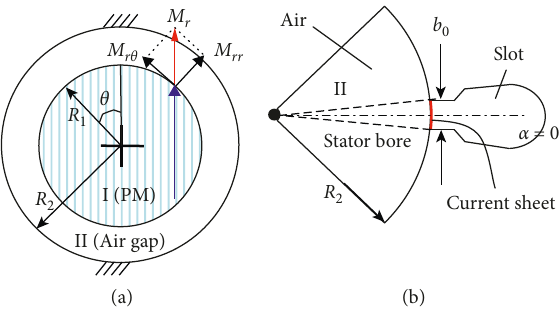
Figure 2: Models of the electromagnetic field of the PMSMs. (a) Open-circuit PM field. (b) Armature reaction field.